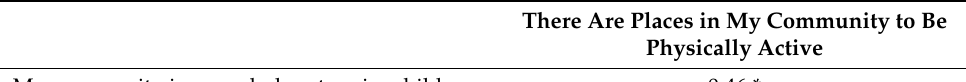
Table 3. Correlations between community livability indicators and places to be physically active in the community.